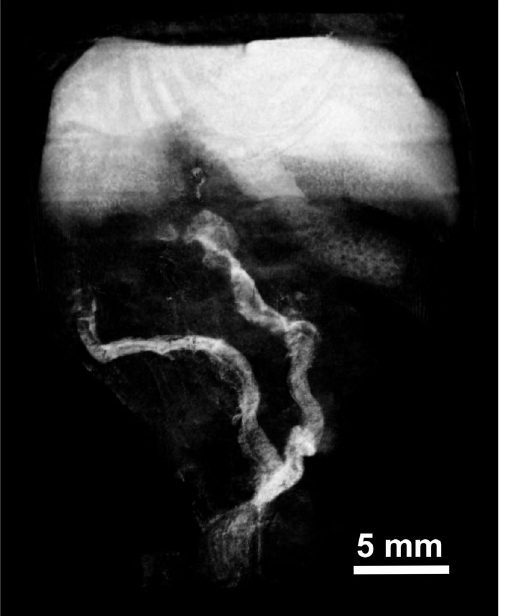
Figure 7. MicroCT coronal view taken 1 week after 1.75 g I/kg IV INP injection in mouse. INPs are seen in the intestines.